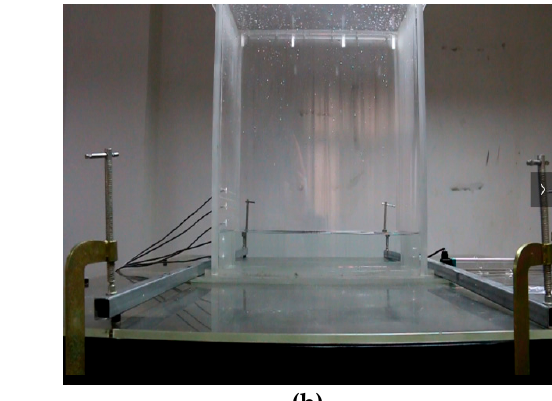
Figure 2. The experimental setup of liquid sloshing ( a ). The motion simulation platform, ( b ). The liquid tank.